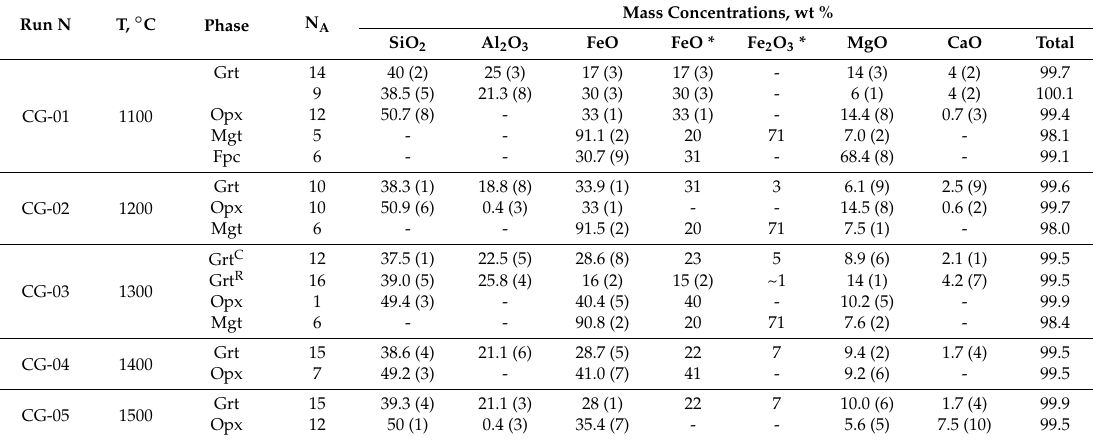
Table 6. Average compositions of silicates and oxides in the carbide–oxide–carbonate system (“mixture-type” experiments) at 6.3 GPa, according to microprobe